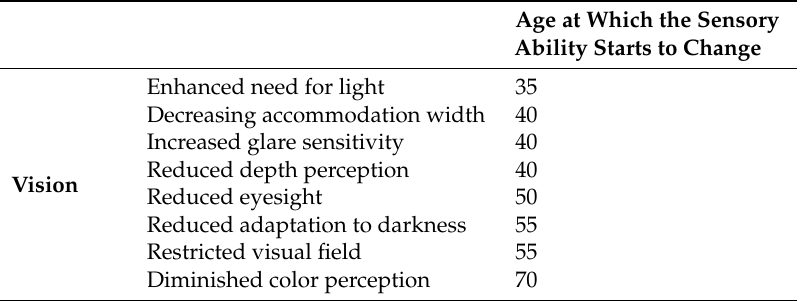
Table 1. Progression of sensory abilities across lifespan, adapted after